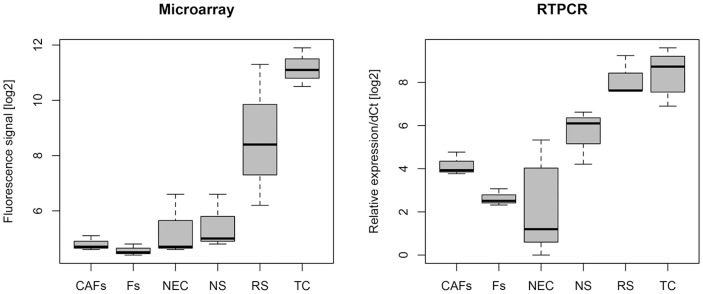
FOXQ1 is expressed in tumor cells and reactive stroma.Boxplot of FOXQ1 mRNA levels in laser dissected human CRC samples measured by microarray n = 3 and qRT-PCR n = 3–5. TC = tumor cells, NEC = normal epithelial cells, NS = normal stroma, i.e. stromal tissue surrounding normal colonocytes, RS = reactive stroma, i.e. stromal tissue with increased infiltration of inflammatory cells surrounding tumor cells, F = primary cells cultures of fibroblasts and CAF = cancer-associated fibroblasts.